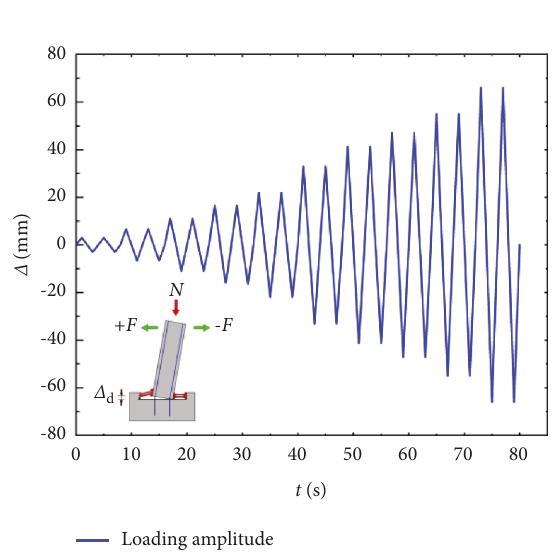
Figure 8: Loading scheme.